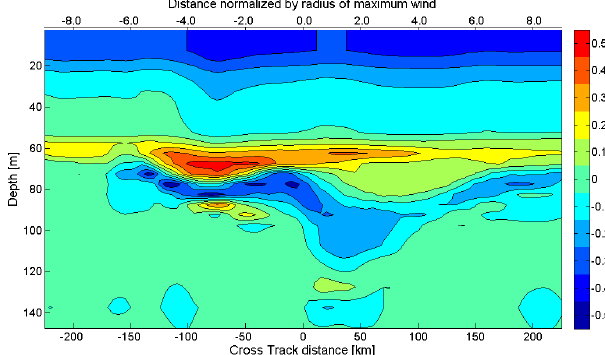
Figure 12. Double-TC surface temperature anomaly (see Eq. 1). Here, the distance perpendicular to the best track is plotted on the Fig. 12. Double-TC surface temperature anomaly (see EQ. 1). Here, the distance 3 lower x axis with negative values representing the distance to the left of the track and positive values the distance to the right of the perpendicular to the best track is plotted on the lower x-axis with negative values represent 4 track. The upper x axis presents the same distance but normalized the distance to the left of the track, and positive values the distance to the right of the track. 5 by the radius of maximum wind, which is 25km in this case. Color The upper x-axis present the same distance but normalized by the radius of maximum wind 6 scale represents temperature anomaly [ ◦ C]. which is 25 km in this case. Color scale represents temperature anomaly [C]. 7